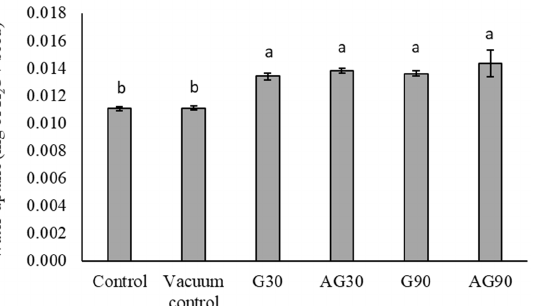
Figure 5. Water uptake of the Control (untreated), seeds exposed to vacuum conditions (Vacuum control) and CP-treated seeds in the glow regime for 30 (G30) or 90 s (G90), and the afterglow regime for 30 (AG30) or 90 s (AG90). Displayed values are the mean ± SE of three replications. Different letters (a,b) indicate statistically significant differences among treatments according to Duncan’s test ( p < 0.05).